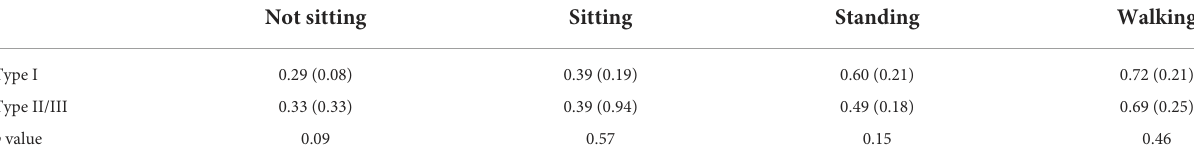
TABLE 9 The difference between utility values of Type II and III SMA patients under and above 16. Not sitting Sitting Sitting supported